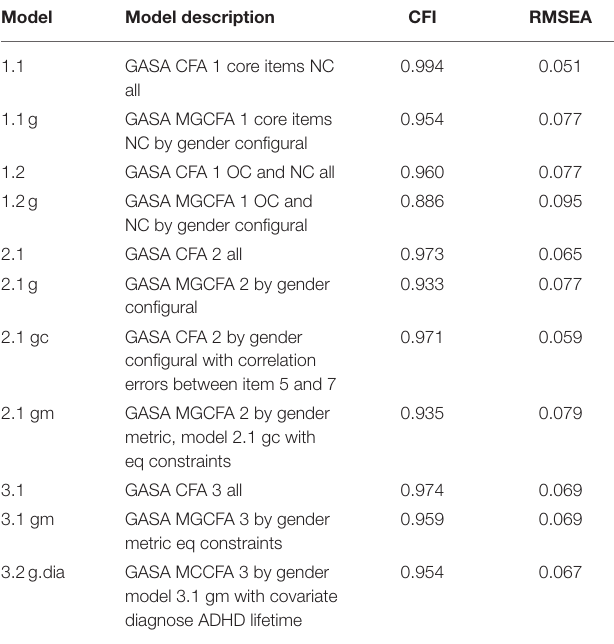
TABLE 3 | Goodness of fit Indexes for the one-, two- and three-factor solutions of GASA.